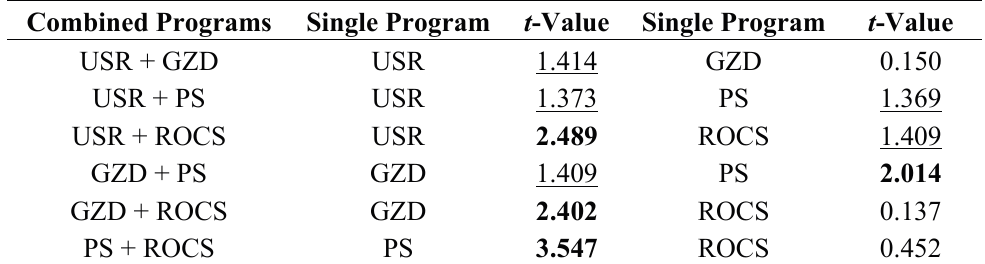
Table 5. Student’s t -test between consensus method and individual methods (EF 2% ). Combined Programs